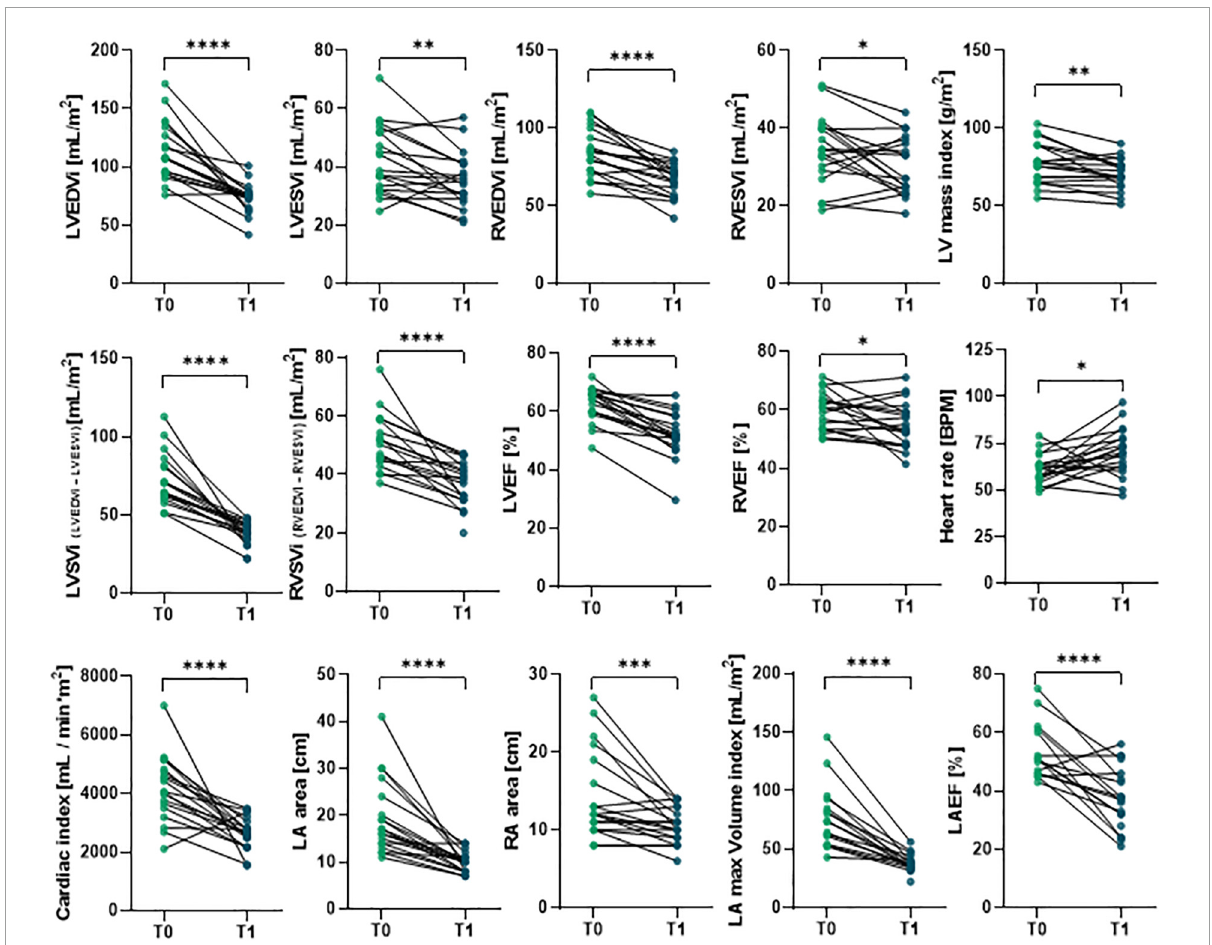
FIGURE1 Comparison of preoperative and postoperative CMRI results in primary MR patients undergoing MVR surgery. The CMRI was performed on patients undergoing MVR surgery ( n = 19) before (T0) and 6 months after (T1) surgery. Individual data are shown for each patient at both time points; statistical comparison between T0 and T1 was performed by paired Student’s t -test or the Wilcoxon test depending on data distribution. ∗ p < 0.05; ∗∗ p < 0.01; ∗∗∗ p < 0.001; ∗∗∗∗ p <